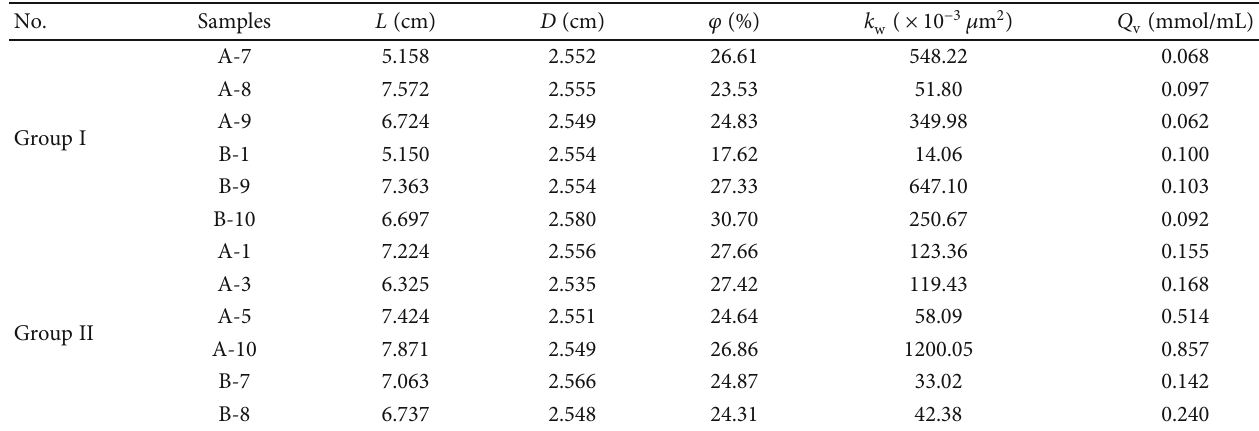
Figure 6: Multifunctional core displacement experimental apparatus. Table 1: The basic physical parameters of core